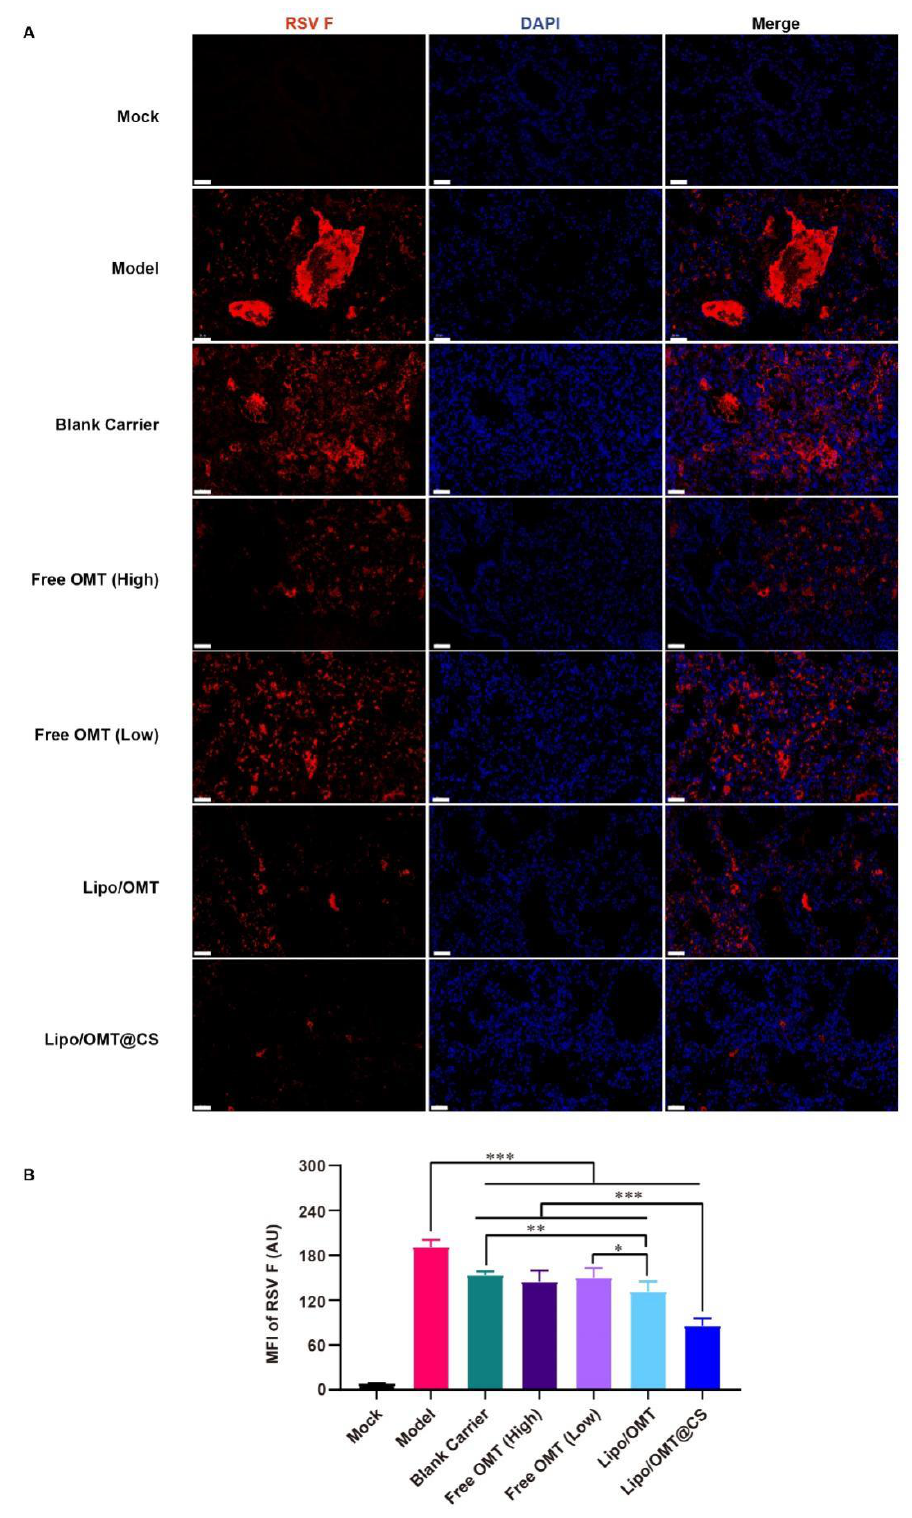
Figure 7. Immunofluorescence assay for OMT liposomal preparations on RSV-infected mice . ( A ) The representative images of each group were captured by confocal microscope (Scale bar = 50 μ m). ( B ) Statistical result for the mean fluorescence intensity (MFI) of RSV F that calculated by Image J software from 8 equal sized images. All the data were expressed as mean + SD ( n = 8). * p < 0.05, ** p < 0.01, *** p < 0.001.